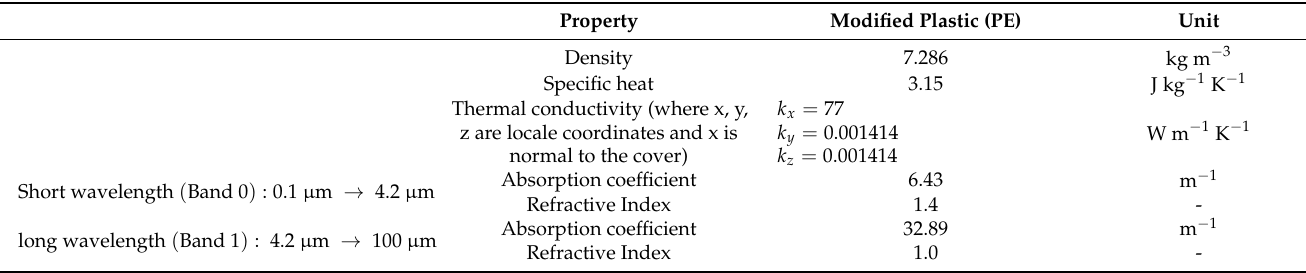
Table A1. The physical and optical material properties of greenhouse cover with e x = 300 µ m and e m = 8 cm.